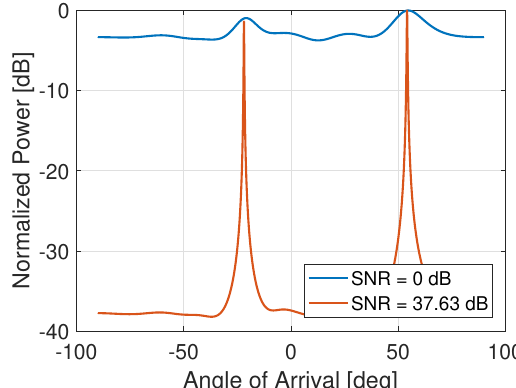
Figure 22. Capon spatial spectrum estimate of range-compressed range line with instantaneous SAR signal coming from 54° and RFI source at −